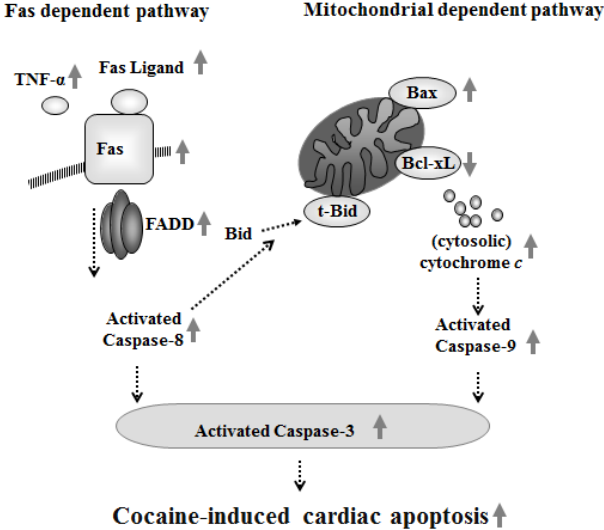
Figure 6. Our proposed major hypothesis: cardiac Fas-dependent and mitochondrial-dependent apoptotic pathways might be more activated after chronic cocaine administration. Cardiac Fas-dependent apoptotic pathway increased due to increases in TNF- α , Fas ligand, Fas, FADD, activated caspase-8, and activated caspase-3. Cardiac mitochondria-dependent apoptotic pathway increased due to decreases in Bcl-xL and increases in t-Bid/Bid, Bax, Bak/Bcl-xL, Bax/Bcl-2, cytochrome c release, activated caspase-9, and activated caspase-3. Up arrows and down arrows on the right side represent increases and decreases,